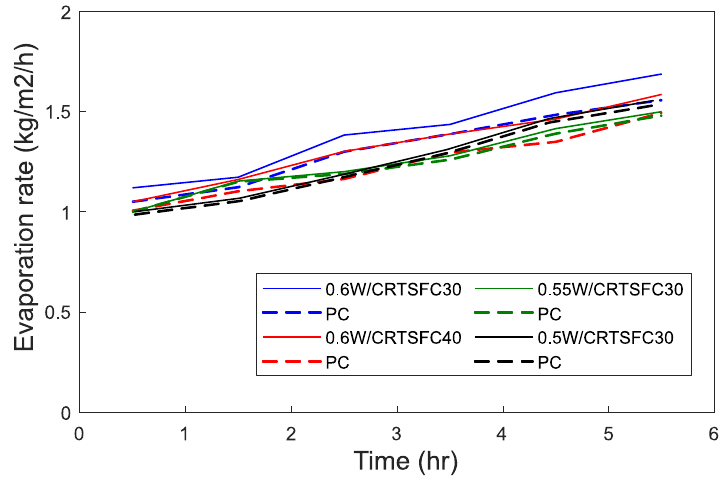
Figure 10. Effect of water cement ratio on evaporation rates (T = 36 °C, Wind speed = 4.7 m/s).